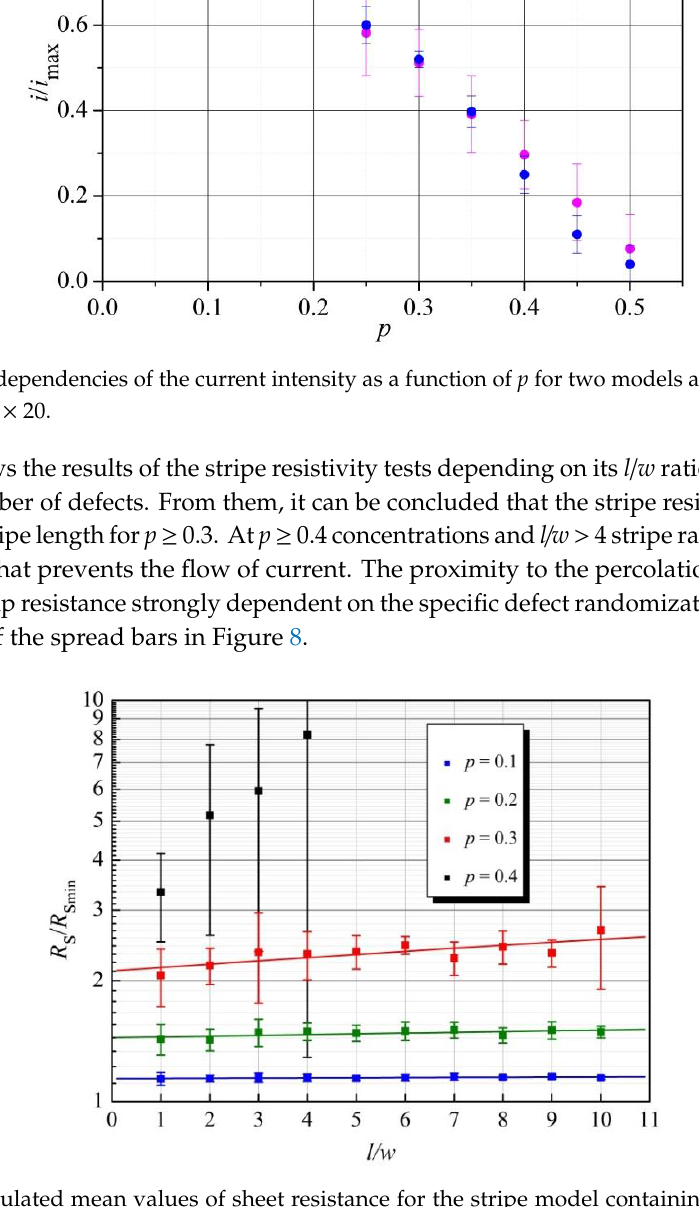
Table 1. Linear regression results of relative sheet resistance as a function of l/w stripe ratio ( 𝑅 𝑠 ≈ 𝑎 𝑙 + 𝑏) . 𝑅 𝑠min 𝑤